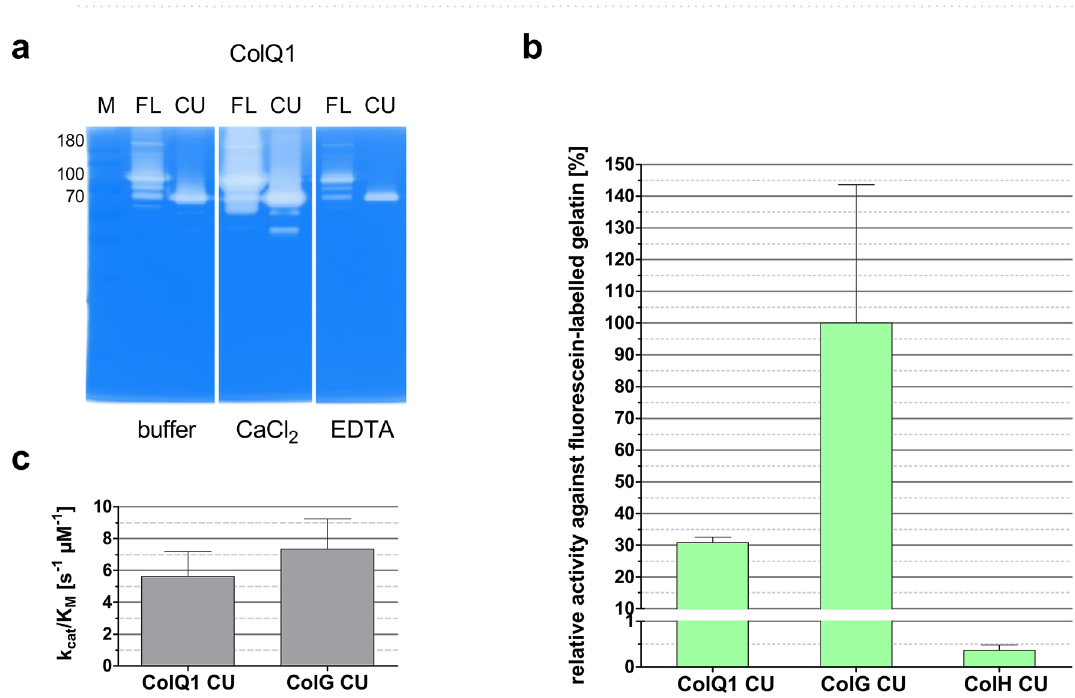
Figure 5. Activity of bacterial collagenases against gelatin ( a ) Zymogram showing the gelatinolytic activity of ColQ1 FL and CU in developing buffer without additives, with 5 mM EDTA and with 5 mM CaCl 2 added. Clear regions against blue background indicate gelatin in the gel has been cleaved. ( b ) Activity of the collagenase units of ColG, H and Q1 against fluorescein-labelled gelatin (DQ gelatin, Molecular Probes). ( c ) Catalytic efficiency (k cat /K M ) of ColG CU and ColQ1 CU towards gelatin from rat tail determined by discontinuous degradation assay using fluorescamine detection of neo-N-termini. Error bars indicate standard error of nonlinear Michaelis–Menten